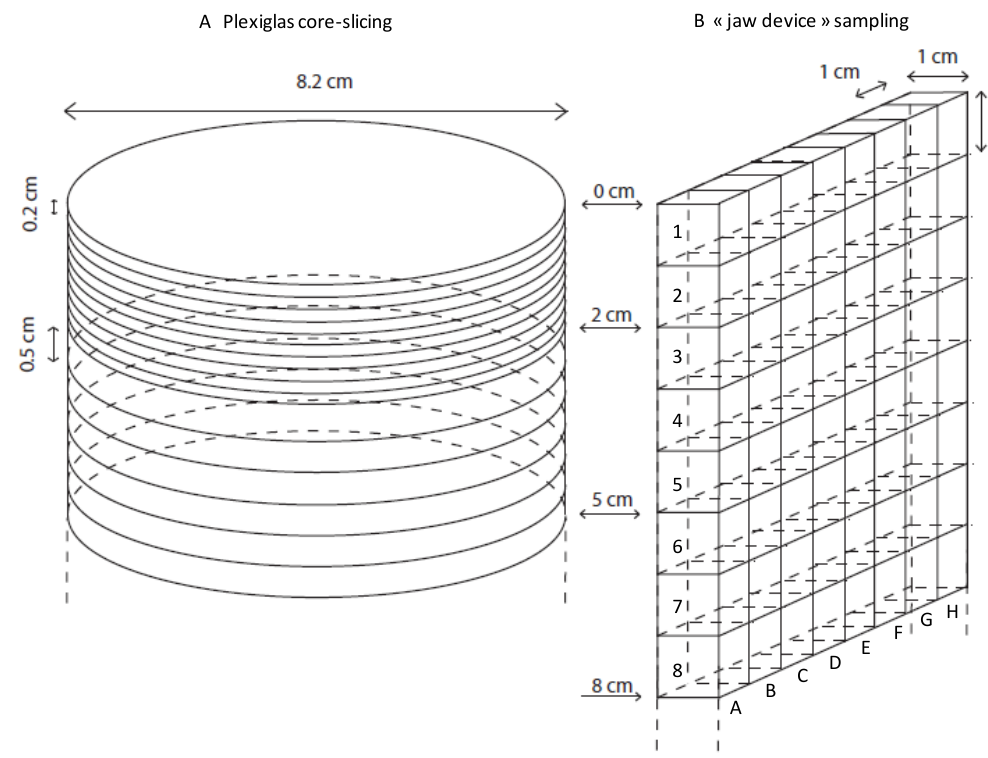
Figure 2. Sediment sampling methodology for living foraminiferal analyses. (a) Usual 1-D hand coring and layer slicing. (b) Sediment plate sampling with the second jaw of the “jaw device” (Fig. 1) and representation of the sediment cubic